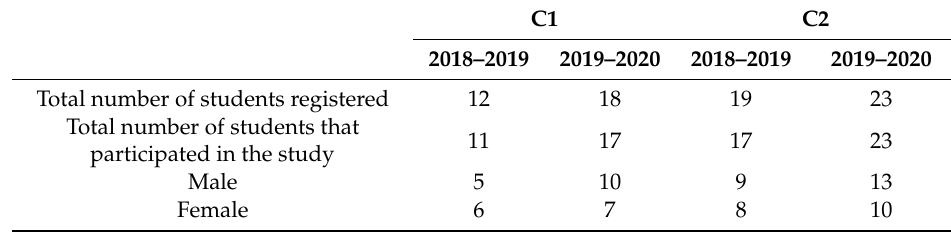
Table 1. Distribution of the students who participated and evaluated the e-learning activities by course and academic year.